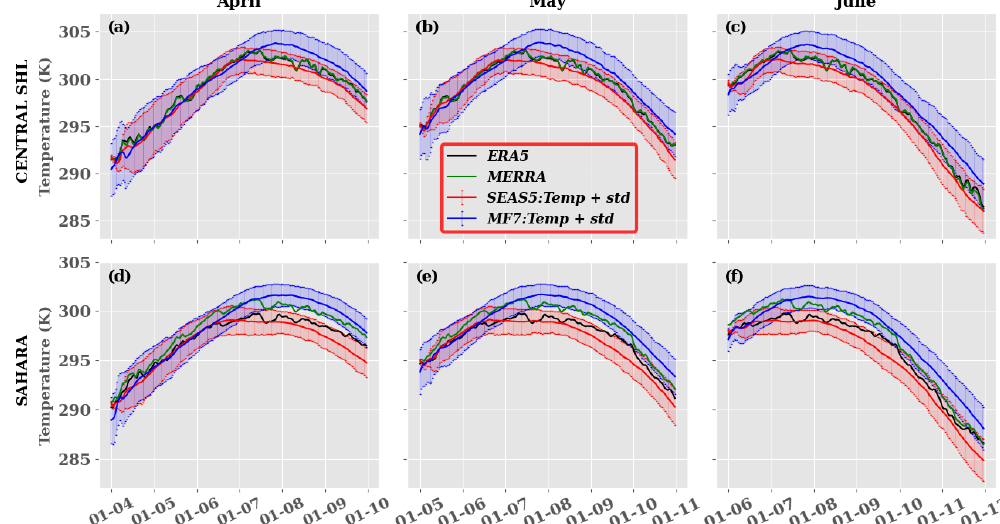
Figure 6. Climatology and spread of mean daily temperature during 1993–2016 at different initialization months for a 6-month forecast: (a, d) April, (b, e) May and (c, f) June for the (a–c) central SHL box and (d–f) Sahara. Bold black, green, red and blue curves refer to the mean T850 of ERA5, MERRA, SEAS5 and MF7 respectively; red and blue bars represent the inter-member spreads for SEAS5 and MF7 respectively. The computation was made using the ensemble mean of forecast models. The y axis indicates temperature in kelvins and x axis the